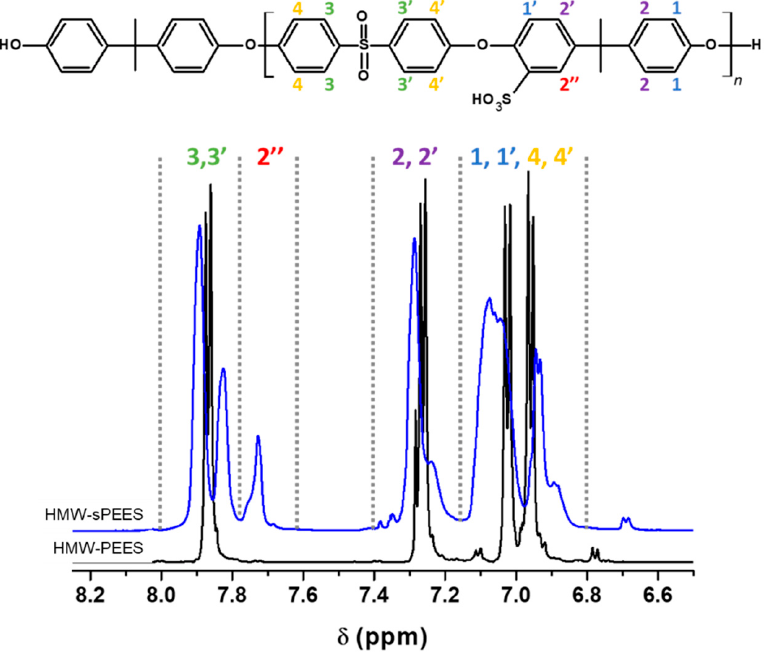
Figure 4. 1 H NMR spectrum of the polymers before (HMW-PEES) and after sulfonation (HMW- sPEES).